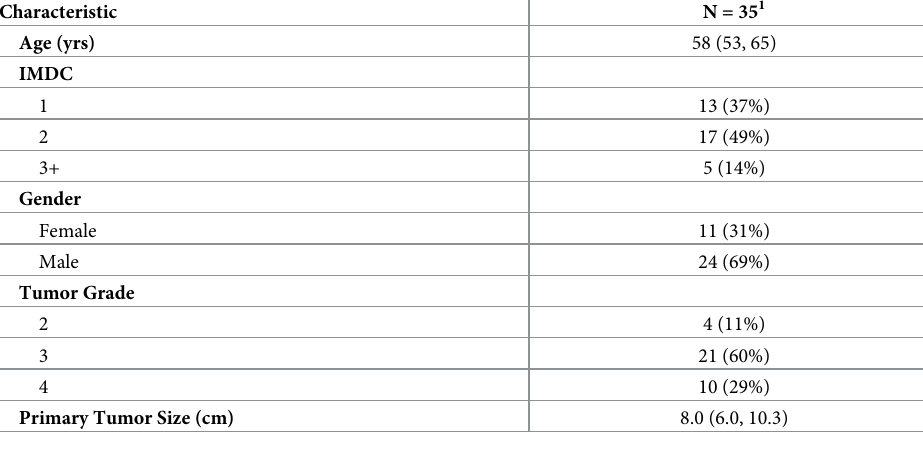
Table 1. Baseline patient characteristics at the time of sample